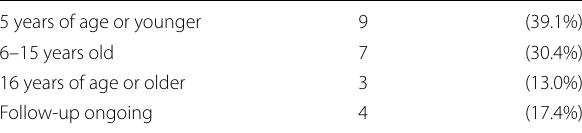
Table 5 Age at the time of follow-up